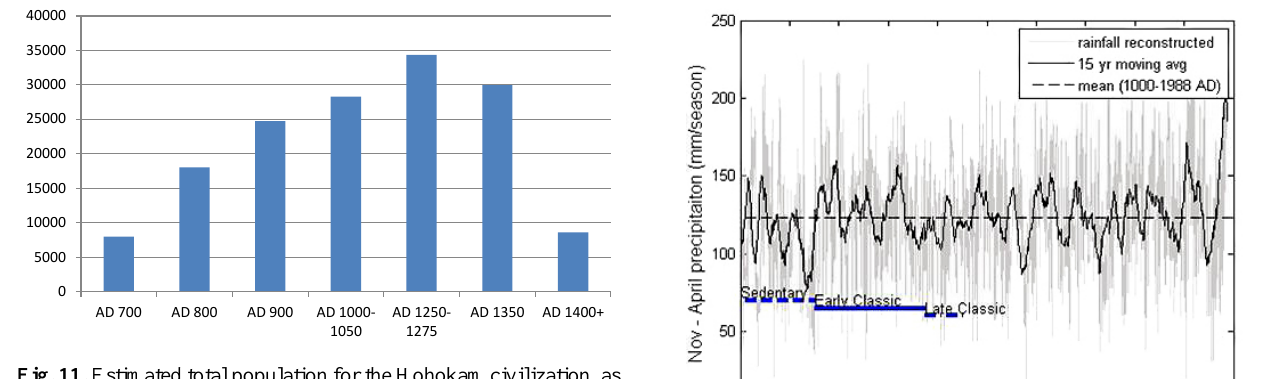
Fig. 11. Estimated total population for the Hohokam civilization, as reconstructed by the Long Term Vulnerability and Transformation project (http://core.tdar.org/dataset/1582). 467